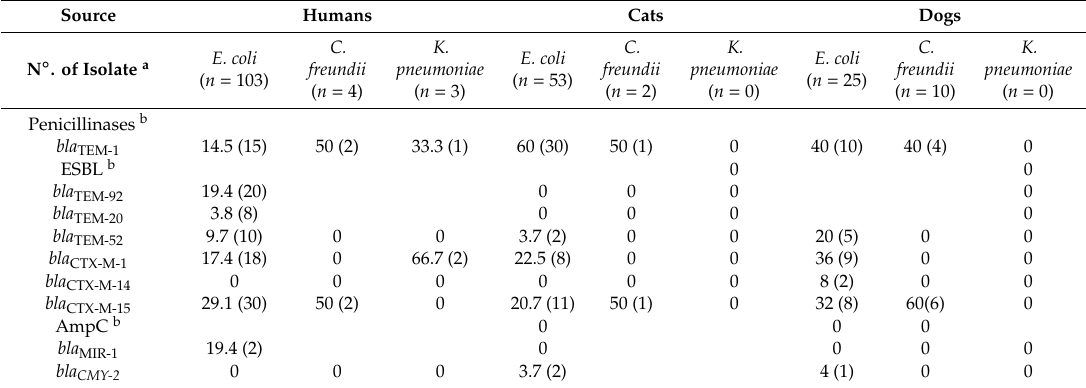
Table4. Distributionof β -lactamasegenes(%)in Enterobacteriaceae isolatesofhumancatanddogisolates. Source Humans Cats Dogs